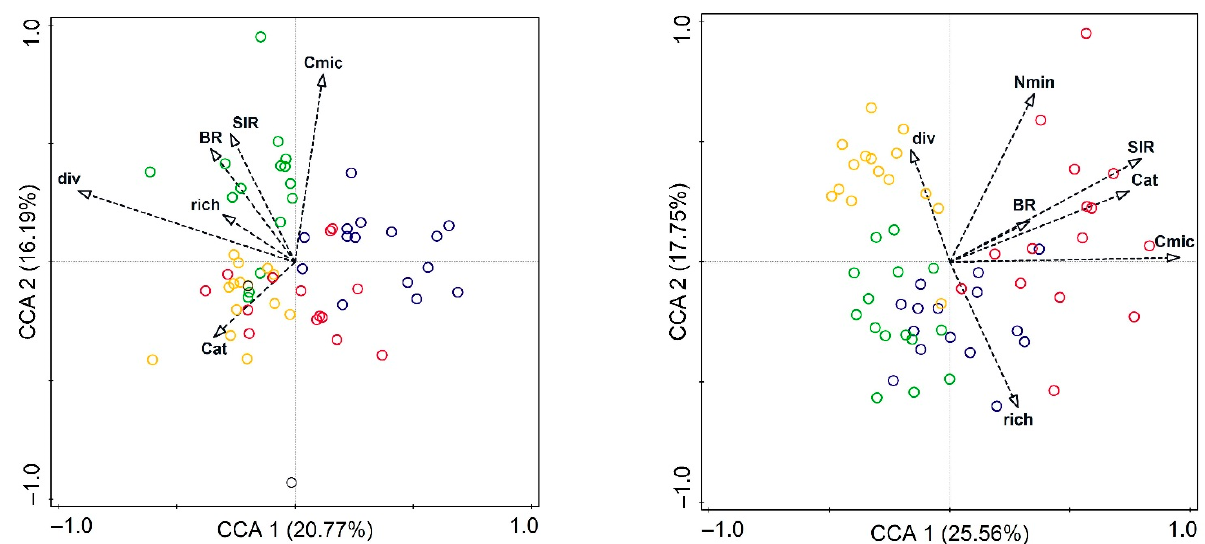
Figure 2. Canonical correspondence analysis for soil microbial community properties in relation to stand tree species composition within the O-horizon ( left ) and A-horizon ( right ). Arrows represent the direction of the steepest increase of individual microbial properties. Circles represent individual sampling sites, with color distinctions of dominant tree species in the stands (blue— Pseudotsuga menziesii ; green— Picea abies ; yellow— Fagus sylvatica ; red— Acer pseudoplatanus ).